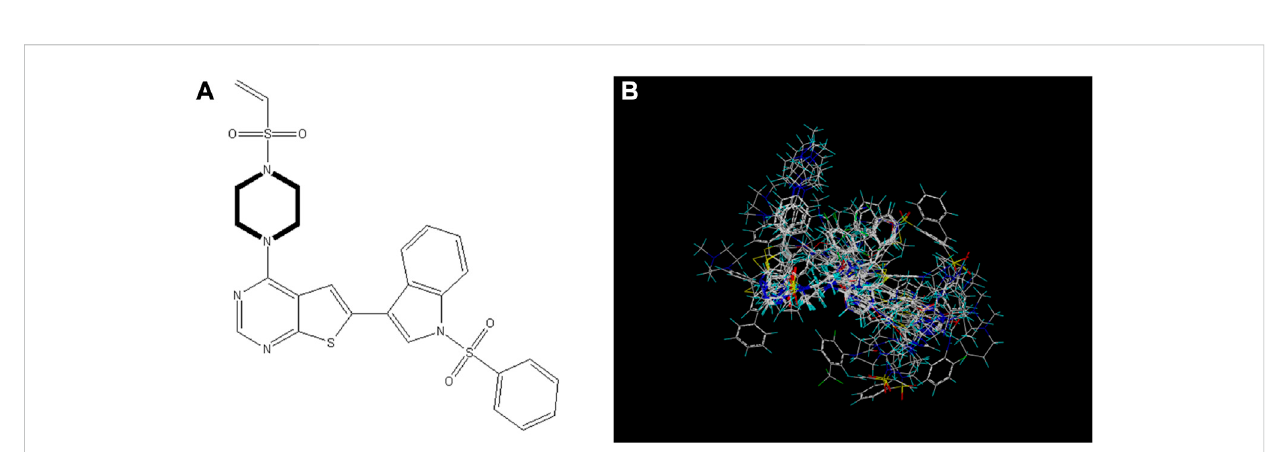
FIGURE 2 Compound14isusedasatemplateforallcompoundalignment. (A) Thecommonlyusedalignmentstructureincompound14(showninbold), (B) all compounds are arranged with 14 as a